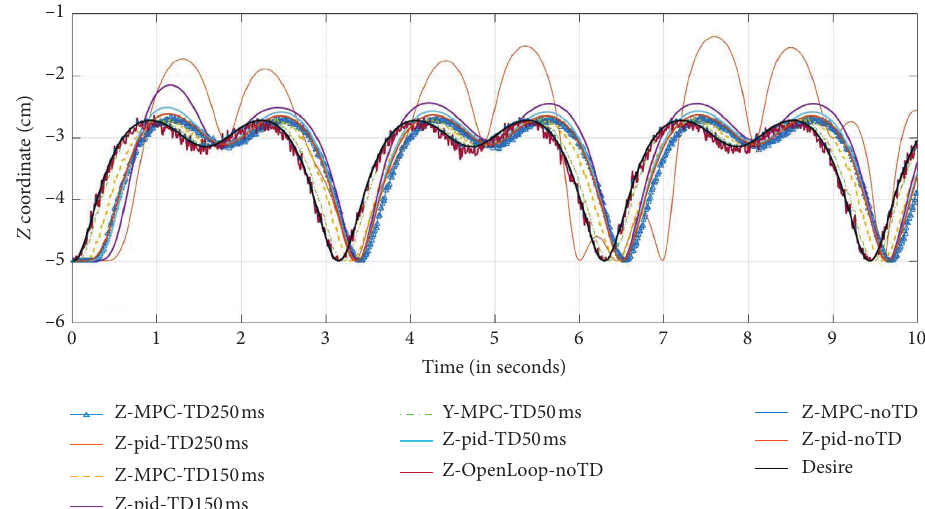
Figure 9: The performance of the Z -axis motion trajectory of the tip of puncture needle under different delays and different controllers.